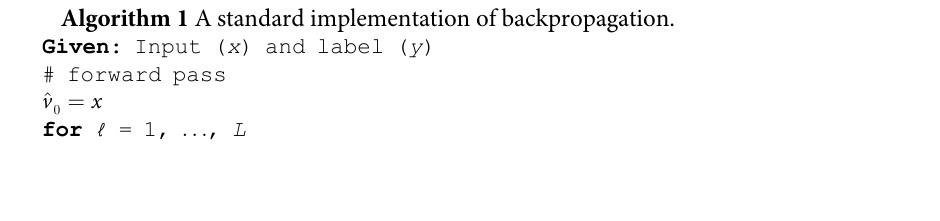
Algorithm 1 A standard implementation of